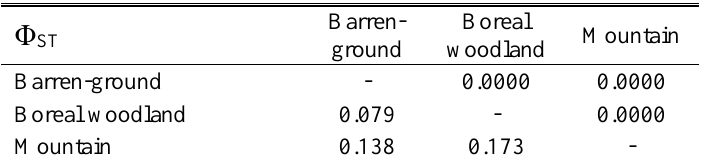
Table A2.4. Pairwise Φ ST values based on mtDNA for the three major groups identified by structure analysis (below diagonal) and pairwise P values (above